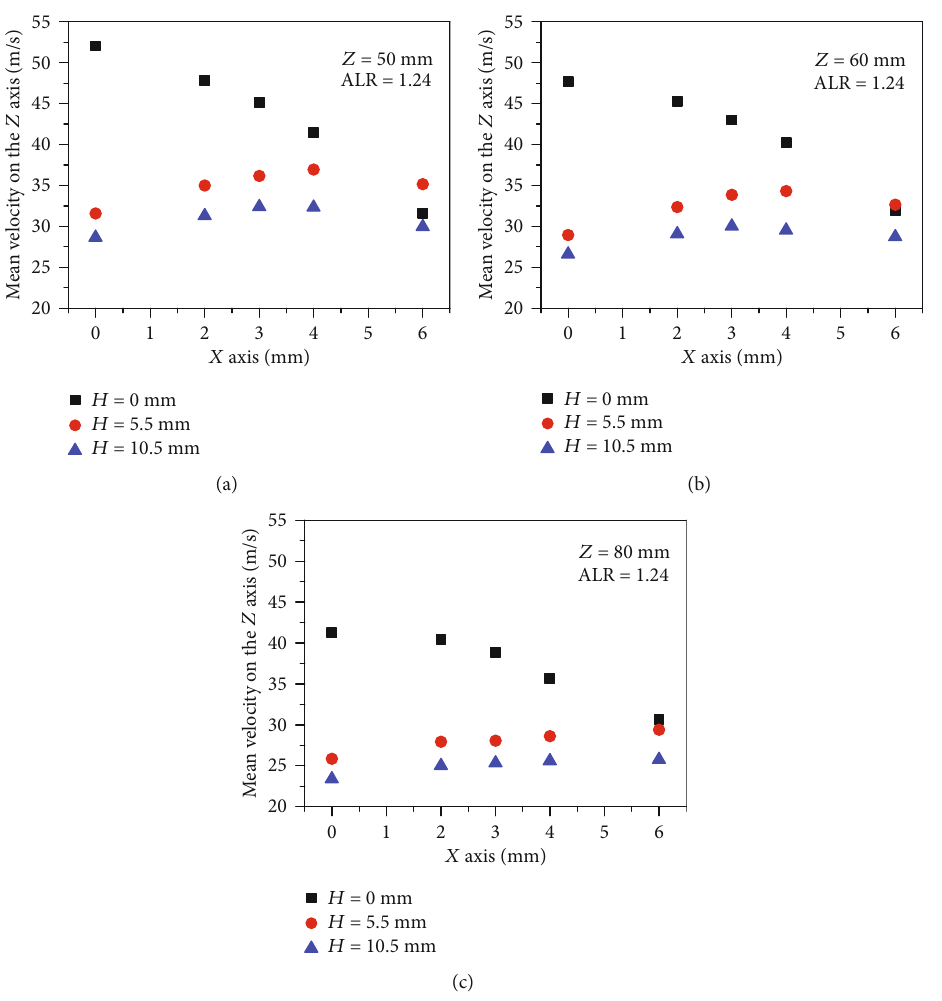
Figure 9: The droplet mean velocity on the Z axis of H series nozzle correlation at test position ( ALR = 1 : 24